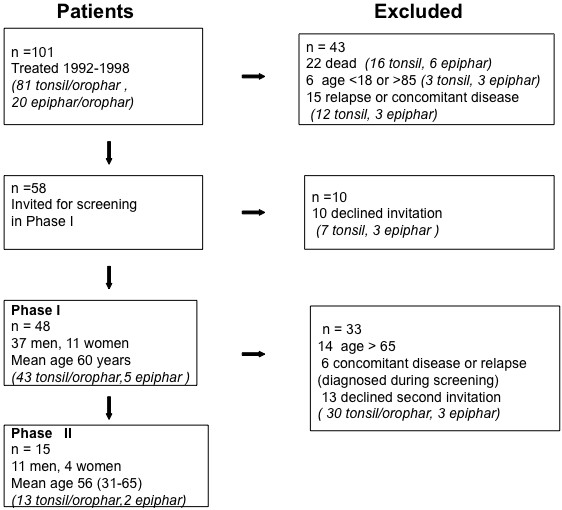
The trial profile. From the patient group participating in the screening, survivors were selected in order to make an extended case-control study. In this process patients more than 65 years or with any concomitant disease discovered during the screening process were excluded. Median time from radiation treatment to the performance of the study was 6 years with range 4-10 years. For characteristics of the patients in the case control-study, see Table 1.